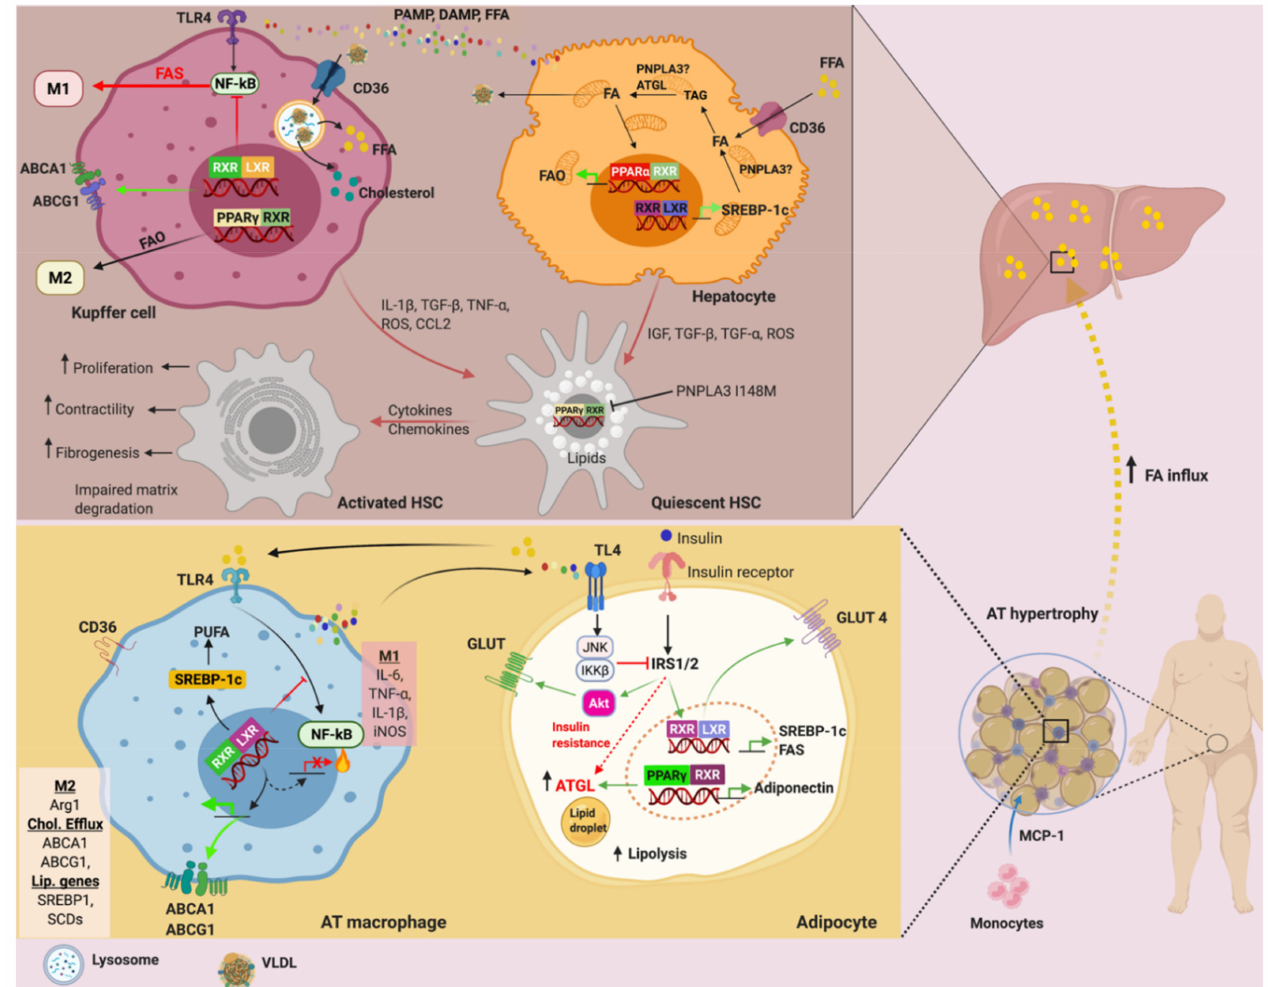
Figure 3. Nuclear receptors and adipose-liver axis in insulin resistance and NAFLD: FAs from hypertrophic adipocytes serve as ligands for TLR4 to induce NF- κ B and subsequent proinflammatory cytokines and chemokines expressions in macrophages. The released cytokines, including TNF- α and IL-6 by macrophages, in turn, activate the TLR4 and induces IR via JNK-I κκ B signaling pathways in adipocytes. In the IR state, ATGL under the control of PPAR γ is upregulated to ensure rapid lipolysis. The released FFA influx the liver, where they are re-esterified into TAG. The inability to get rid of the FAs due to dysregulation of PPAR α , LXR, ATGL and more recently PNPLA3 I148M lead to hepatic steatosis. In addition to its cholesterol homeostatic role, LXR can inhibit M1 activation whiles PPAR γ promotes M2 activation in Kupffer cells. Activation of the Kupffer cells by the inflammatory cues from hepatocytes promotes local inflammatory milieu, further exacerbating steatosis and influence fibrogenesis. In brief, activated Kupffer cells and hepatocytes secretes IL-1 β , TGF- β , TNF- α , CCL2 resulting in the activation of HSC. In addition, the variant PNPLA3 I148M results in the inhibition of PPAR γ via JNK signaling pathways, thus blunting antifibrogenic action and promoting HSC activation [166]. ATGL: adipose triglyceride lipase, CCL2: C–C motif chemokine ligand 2, HSC: hepatic stellate cells, IL-6: interleukin 6, IL-1 β : interleukin 1 β , I κκ B: inhibitor of nuclear factor κ B, IR: insulin resistance, LXR: liver X receptor, JNK: c-Jun N-terminal kinases, NF- κ B: nuclear factor κ B, PPAR: peroxisome proliferator-activated receptor, PNPLA3: patatin-like phospholipase domain containing 3, SFA: saturated fatty acid, TLR4: toll-like receptor 4, TNF- α : tumor necrosis factor α , TGF- β : transforming growth factor β . Created with BioRender.com, accessed on 16 March